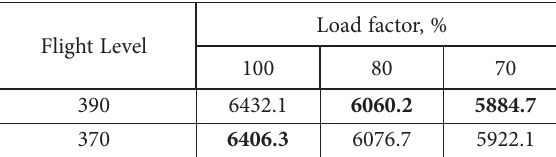
Table 5. Trip fuel in kg, 2000 km flight, ‘New’